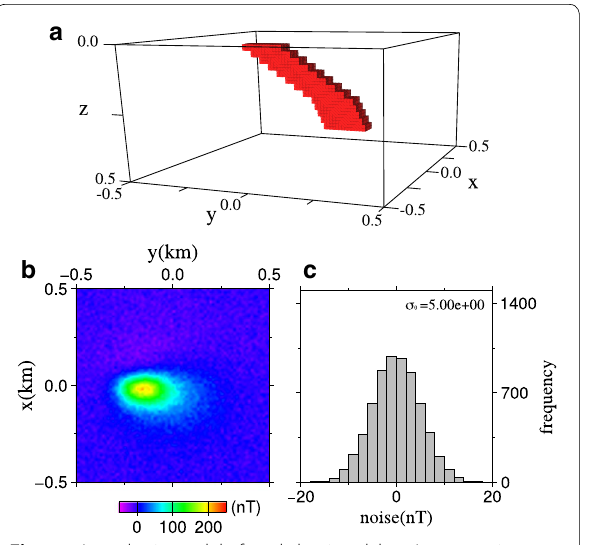
Fig. 14 A synthetic model of a subducting slab. a A perspective view of the synthetic model which displays the all non-zero model elements. The induced magnetization of each block is 2 A/m, and the directions of the ambient geomagnetic field are assumed to be I 75 ◦ and D 25 ◦ . b The total field anomaly computed by this = = synthetic model which is contaminated by an uncorrelated Gaussian 5.0nT . c The noise with zero mean and a standard deviation σ 0 = histogram of the contaminated noise